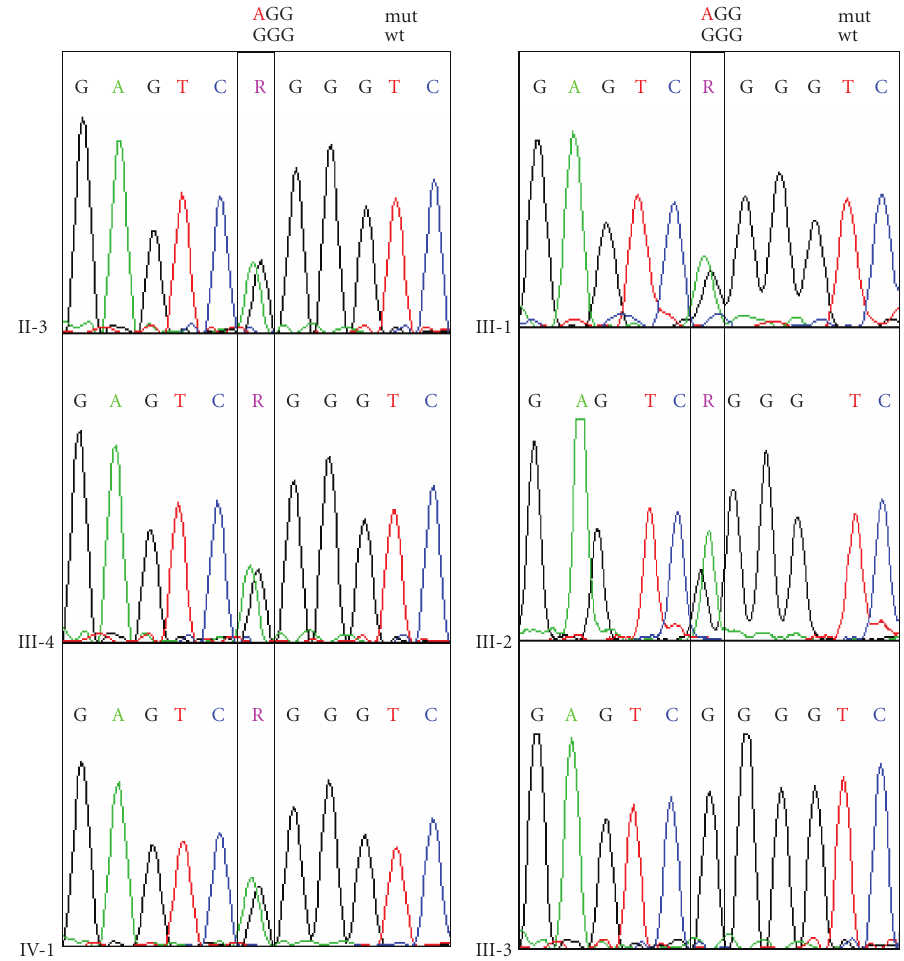
Figure 4: Detection of mutation 7120G > A; G2374R in COL7A1 by sequence analysis in selected family members, except sample III-3, which is wildtype for this